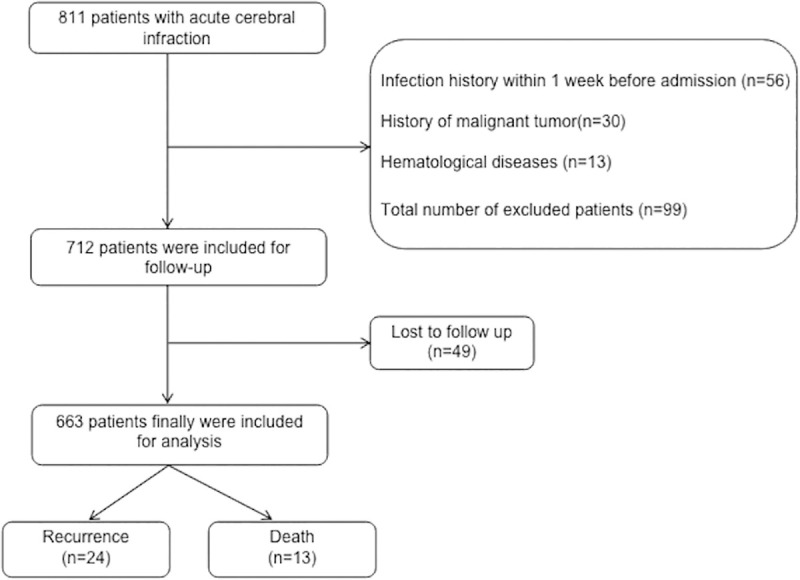
Flow chart of patient enrollment in this study.